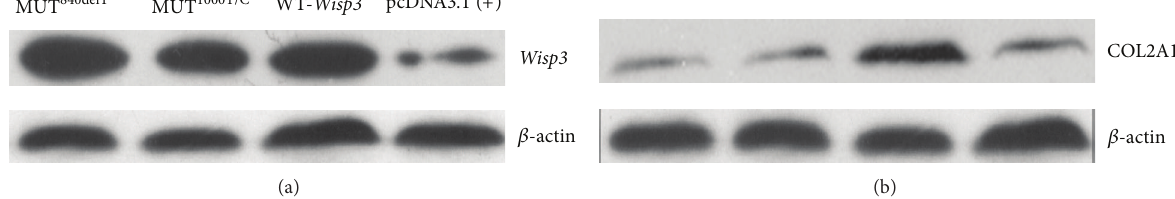
Figure 5: Wisp3 and COL2A1 protein expression in C20/A4 cells transfected with wild and mutant Wisp3 analyzed by western blot.